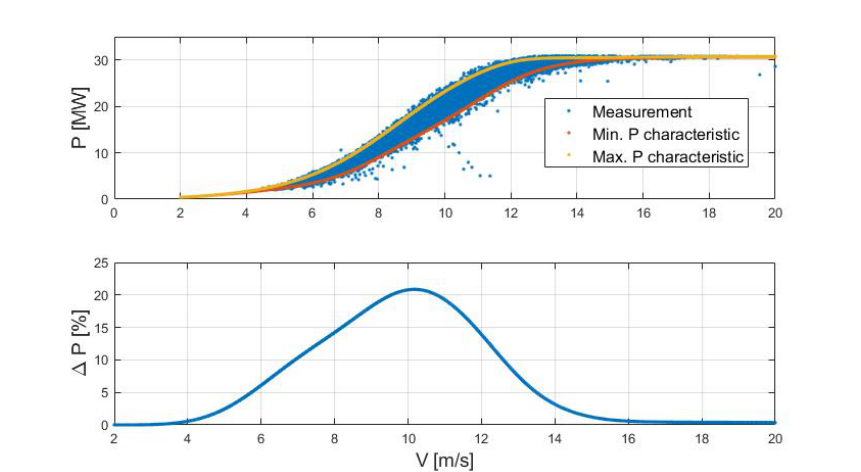
Figure 5. As-measured data (in blue) and approximate minimum/maximum power characteristic envelope (red/yellow), wind power plant FW3.